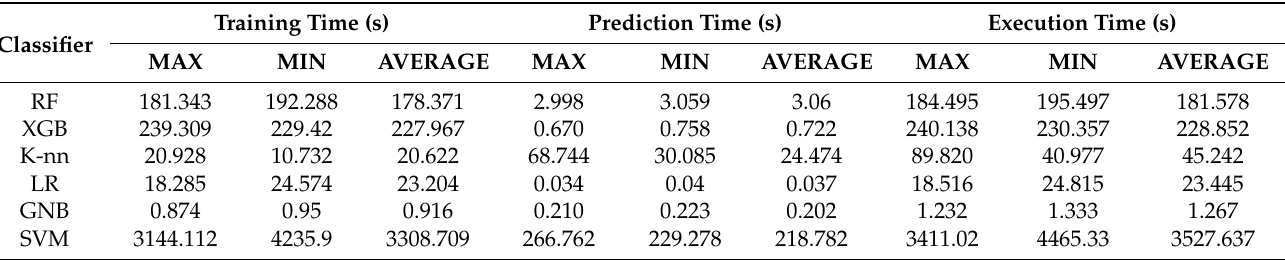
Table 16. Classifiers’ Time Consumption with respect to Aggregation